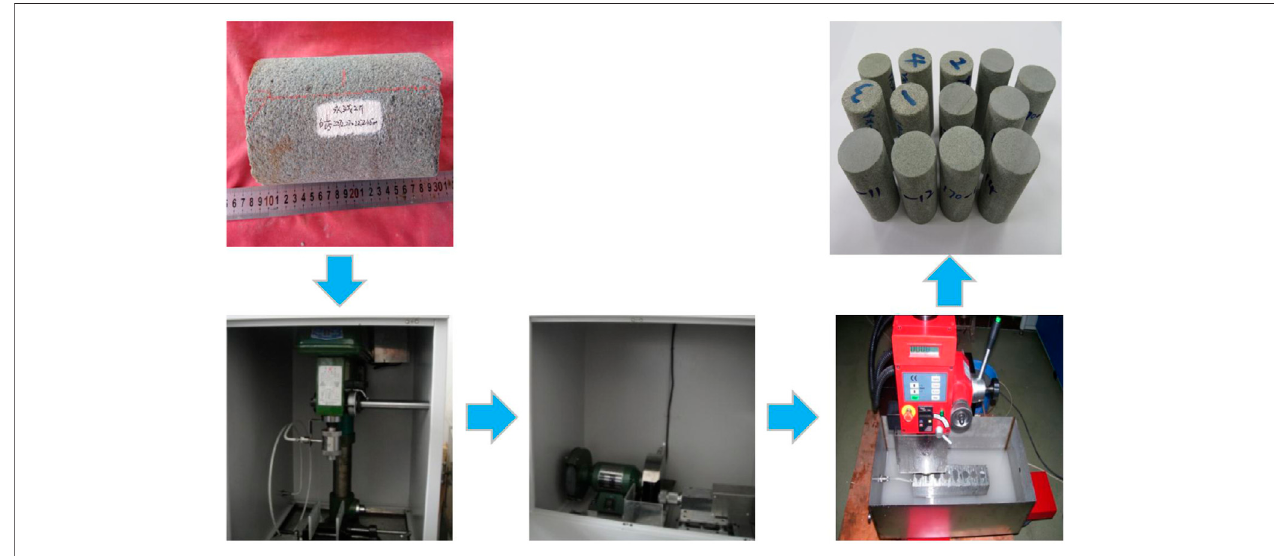
FIGURE 2 | Tight sandstone cores sample process fl ow.